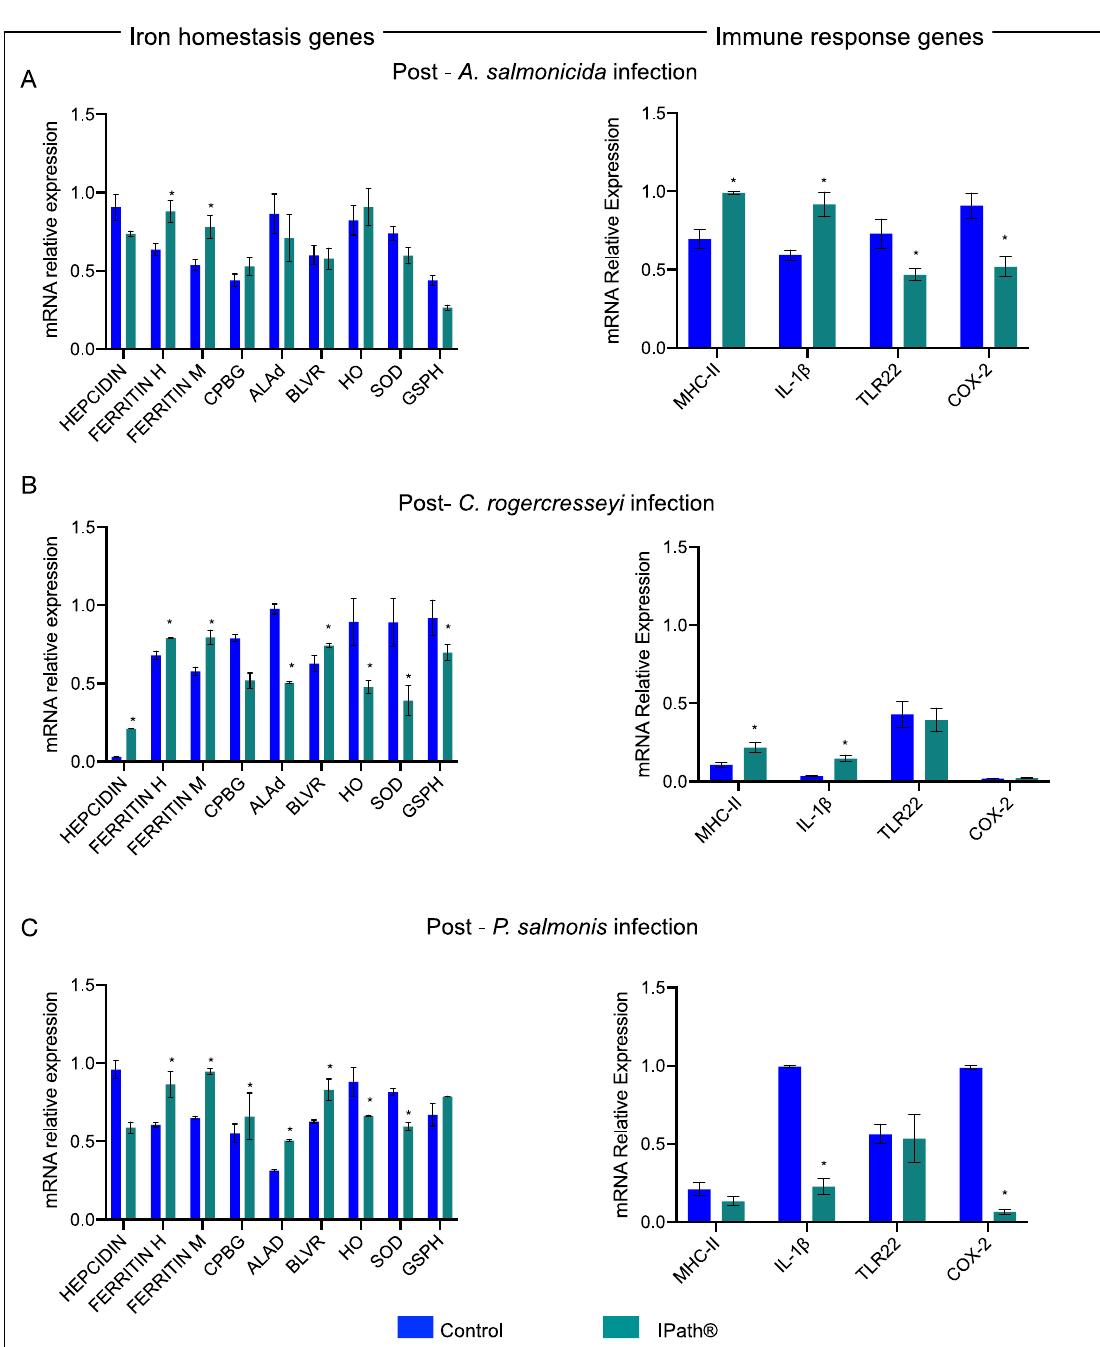
Figure 4. Survival and sea lice burden in Atlantic salmon vaccinated with IPath ® . ( A ) Probability of Atlantic salmon sur- vival on Aeromonas salmonicida infection. ( B ) Caligus rogercresseyi abundance per fish group. * Indicates significant differ- ences between IPath ® -vaccinated fish and the control group ( p < 0.005). ( C ) Probability of Atlantic salmon survival on P. salmonis infection.